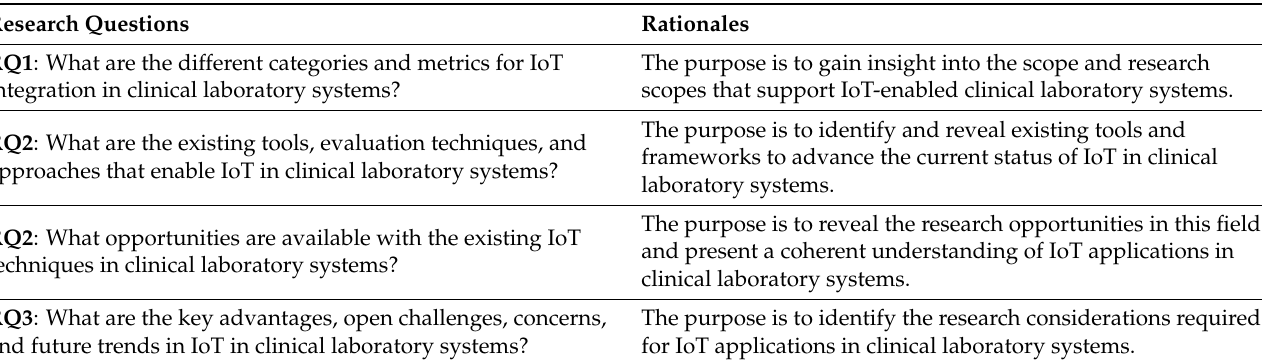
Table 2. Research questions and